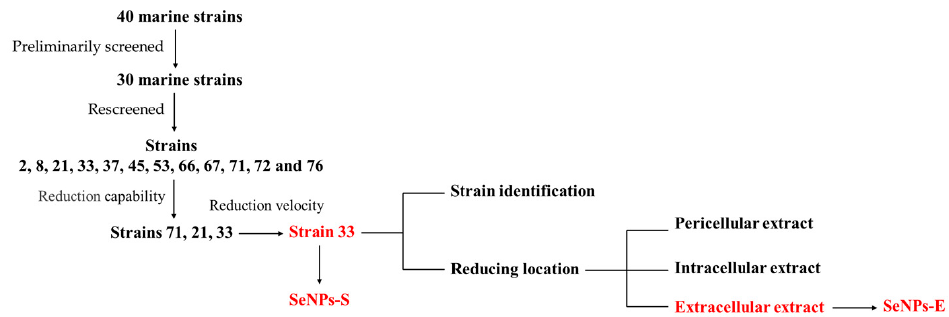
Figure 1. Flowchart for methodology adopted in this study.